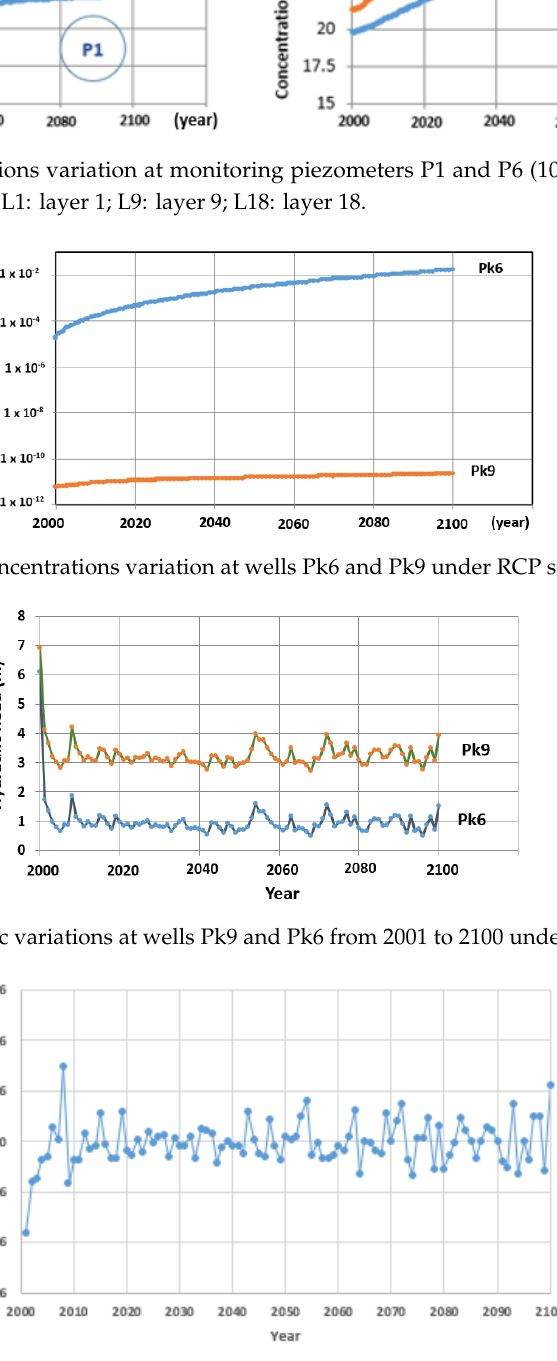
Figure A13. Changes in aquifer reserves from 2001 to 2100 under scenario RCP 8.5.